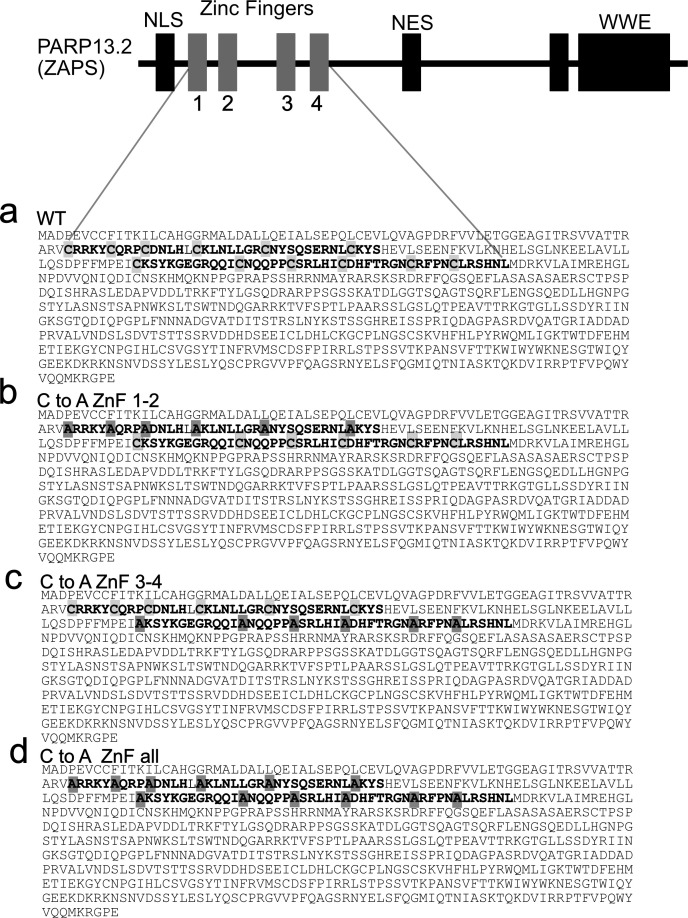
Sequences of CtoA PARP-13.2 mutants.(a) Wild-type PARP-13.2. (b) PARP-13.2 CtoA ZnF 1–2 mutant, sequence verified. (c) PARP-13.2 CtoA ZnF 3–4 mutant, sequence verified. (d) PARP-13.2 CtoA ZnF all mutant, sequence verified.